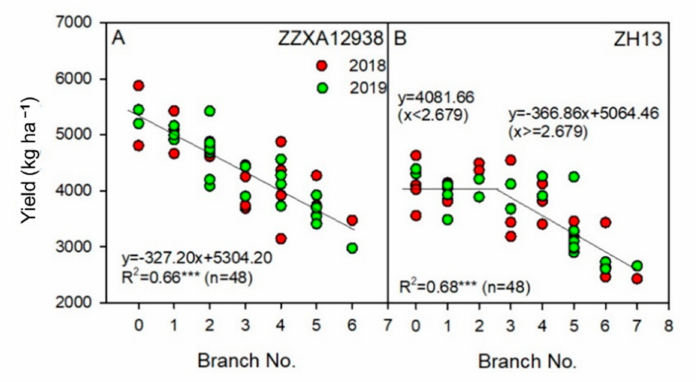
Figure 8. The relationship between seed yield and the branch number for ( A ) ZZXA12938 and ( B ) ZH13. Markers with different colors represent different growing season; *** indicates that the correlation is significant at the p ≤ 0.001